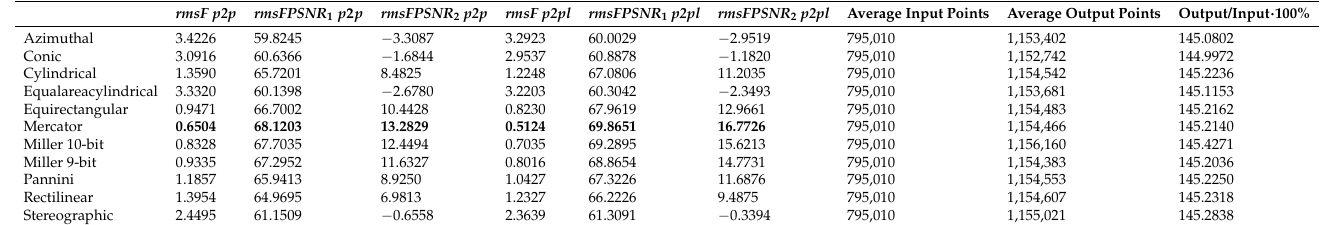
Table 8. Point-to-point (p2p) and point-to-plane (p2pl) objective measures rmsF , rmsFPSNR 1 and rmsFPSNR 2 , after Poisson reconstruction, using different projections with projection area of 1296 × 1160 pixels (approximately 1,500,000), best values are bold; average input and output number of points and their ratio.